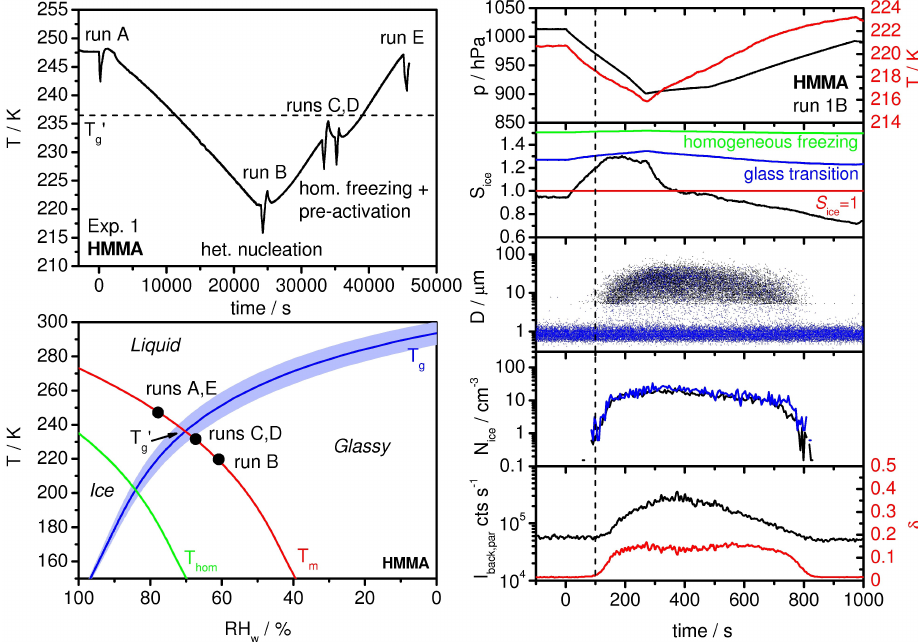
Fig. 4. Top left panel: Temporal evolution of the AIDA gas temperature during Exp. 1 with aqueous HMMA aerosol particles. Bottom left panel: Approximate starting points (black dots) of the experimental trajectories of the five expansion cooling cycles that were performed in the course of the experiment. As in Fig. 1, T g denotes the glass transition temperature with the shaded blue area representing its uncertainty, T m the ice melting temperature, and T hom the homogeneous freezing temperature. Right panel: Time series of various AIDA data during expansion run 1B. The five panels contain the following records: Panel 1: AIDA pressure (black line) and mean gas temperature (red line). Panel 2: Saturation ratio with respect to ice, S ice (black line), measured by TDL absorption. The additional coloured traces show the homogeneous freezing limit (green line), the glass transition curve (blue line), and the line for S ice =1 (red line). Panel 3: Size of individual particles detected by the OPC1 (blue dots) and the OPC2 (black dots). Panel 4: Ice particle number concentration, N ice , inferred from the OPC1 (blue line) and the OPC2 (black line). Panel 5: Backscattered intensity parallel to the incident polarisation state of the laser light, I back,par (black line), and backscattering linear depolarisation ratio, δ (red line). See text for